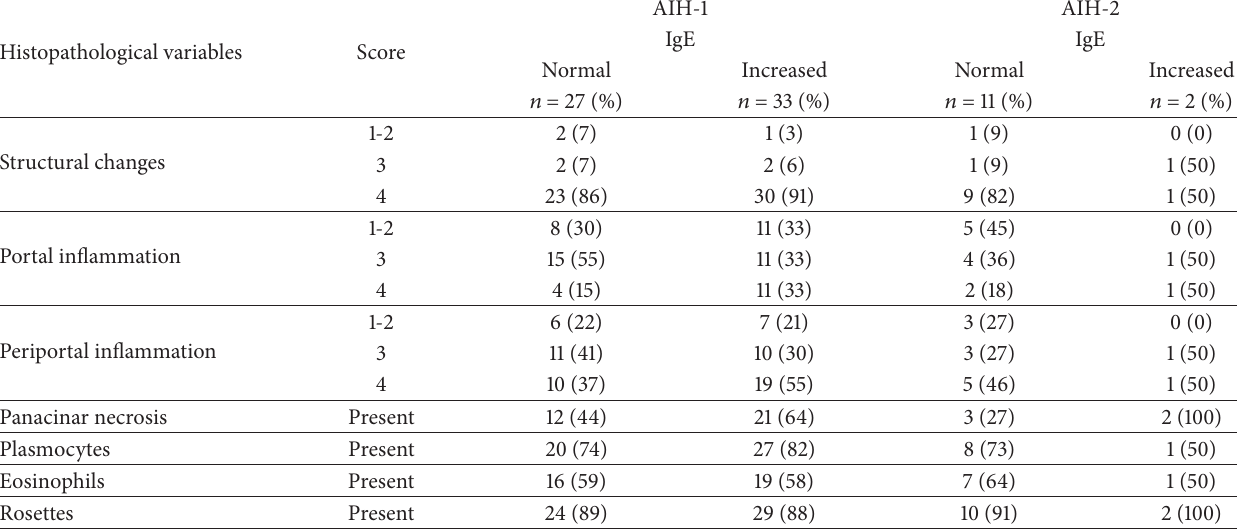
Table 2: Semiquantitative assessment of the histopathological variables by serum IgE levels in AIH-1 and AIH-2 patients. AIH-1 AIH-2 IgE IgE Histopathological variables Score Normal Increased Normal Increased 𝑛 = 27 (%) 𝑛 = 33 (%) 𝑛 = 11 (%) 𝑛 = 2 (%) 1-2 2 (7) 1 (3) 1 (9) Structural changes